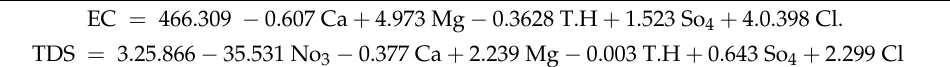
Table 5. MLR model Eq.